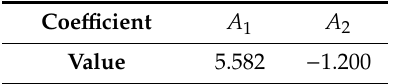
Table 3. Coe ffi cients in Equation (9).